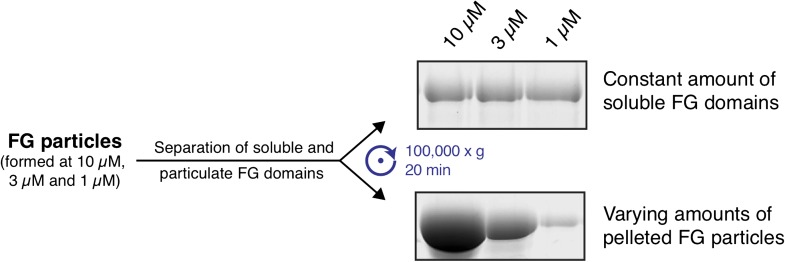
Formation of ScNup116 FG particles at different concentrations.